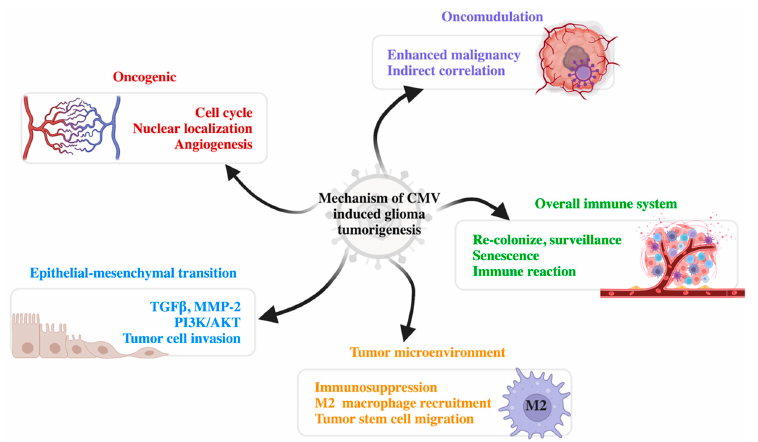
Figure 1. Mechanisms of CMV-induced glioma tumorigenesis. There are five major mechanisms of CMV tumorigenesis: oncogenic, oncomodulation, epithelial-mesenchymal transition, modified tumor microenvironment, and influence on the overall immune system. CMV, cytomegalovirus; TGF β , transforming growth factor β ; MMP-2, matrix metalloproteinase-2; PI3K/AKT, phosphatidylinositol 3-kinase/protein kinase B (PKB).